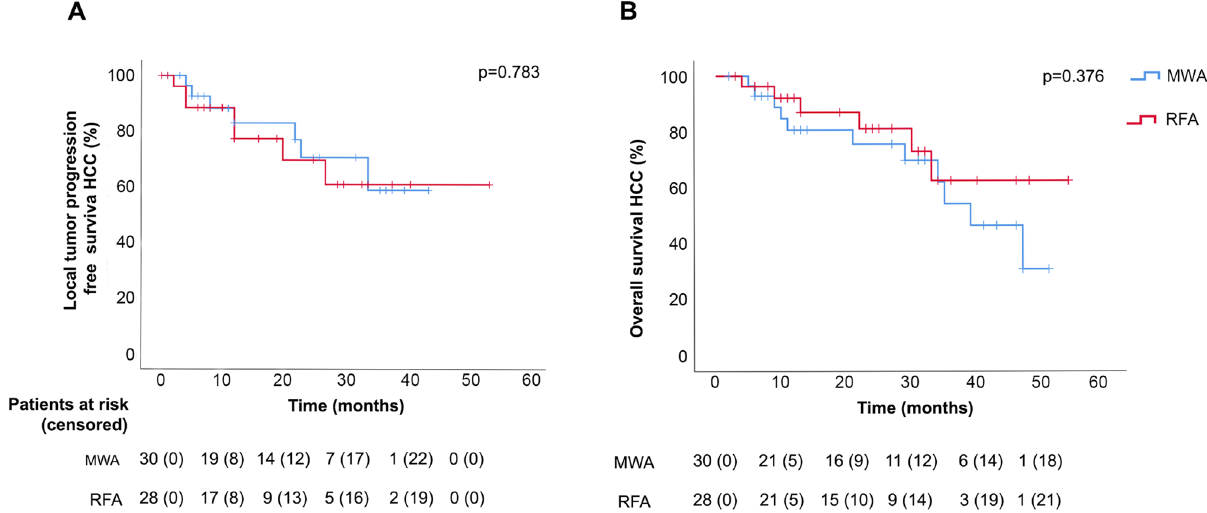
Figure 2. Kaplan–Meier curve of local tumor progression free survival ( A ) and overall survival ( B ) in HCC by group (MWA: microwave ablation; RFA: radiofrequency